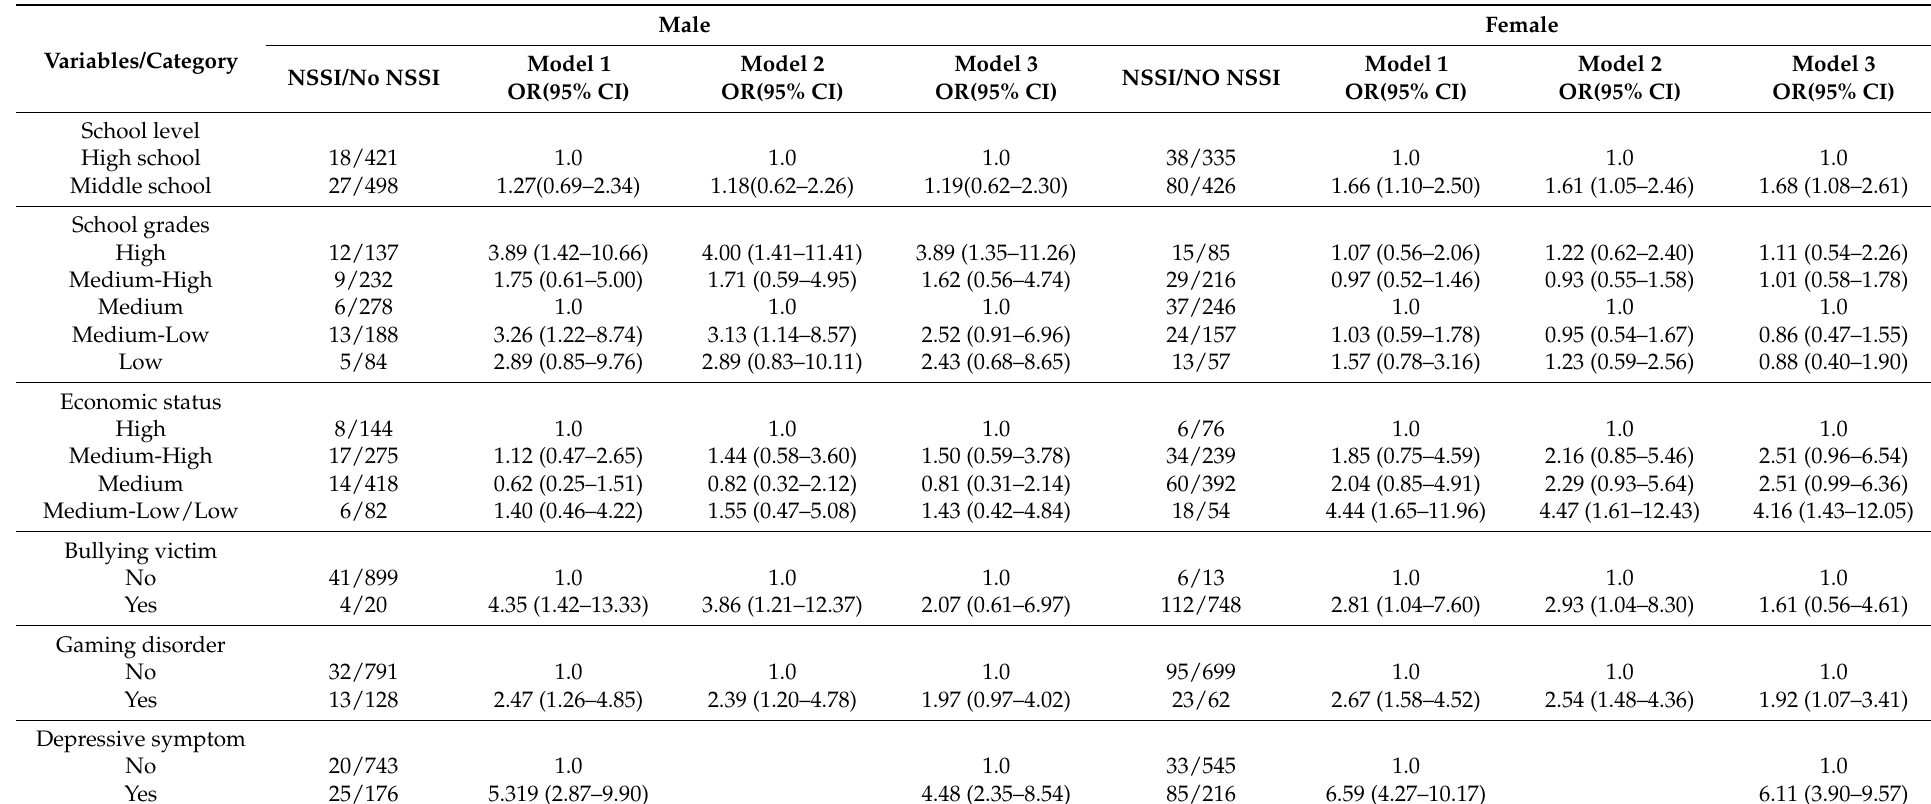
Table 4. Gender differences in related factors with non-suicidal self-injury among adolescents in South